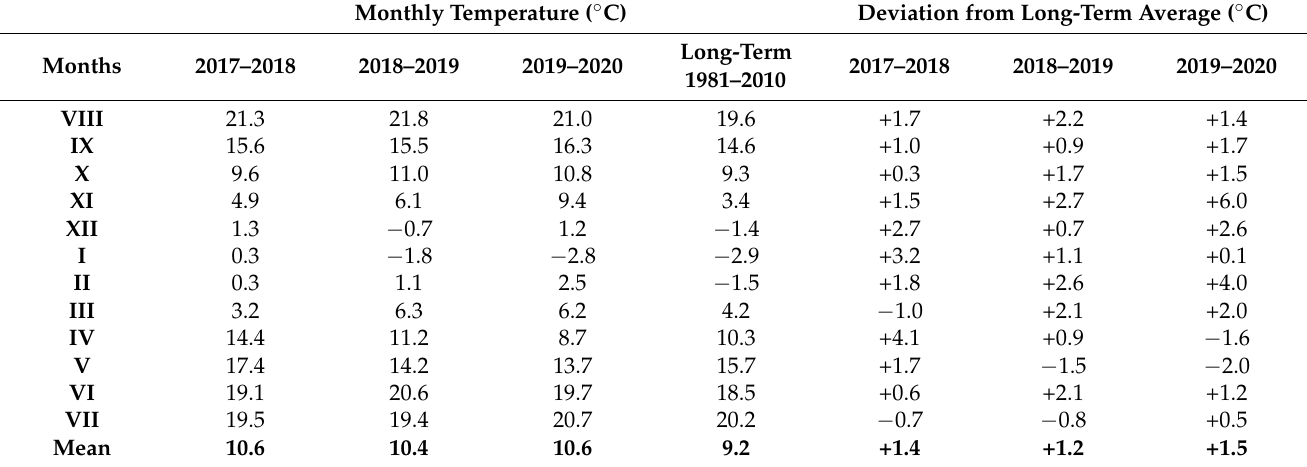
Table 1. Temperature trends during the canola growing seasons (2017–2020) and comparison with the multiannual (1981–2010) mean values of the region.